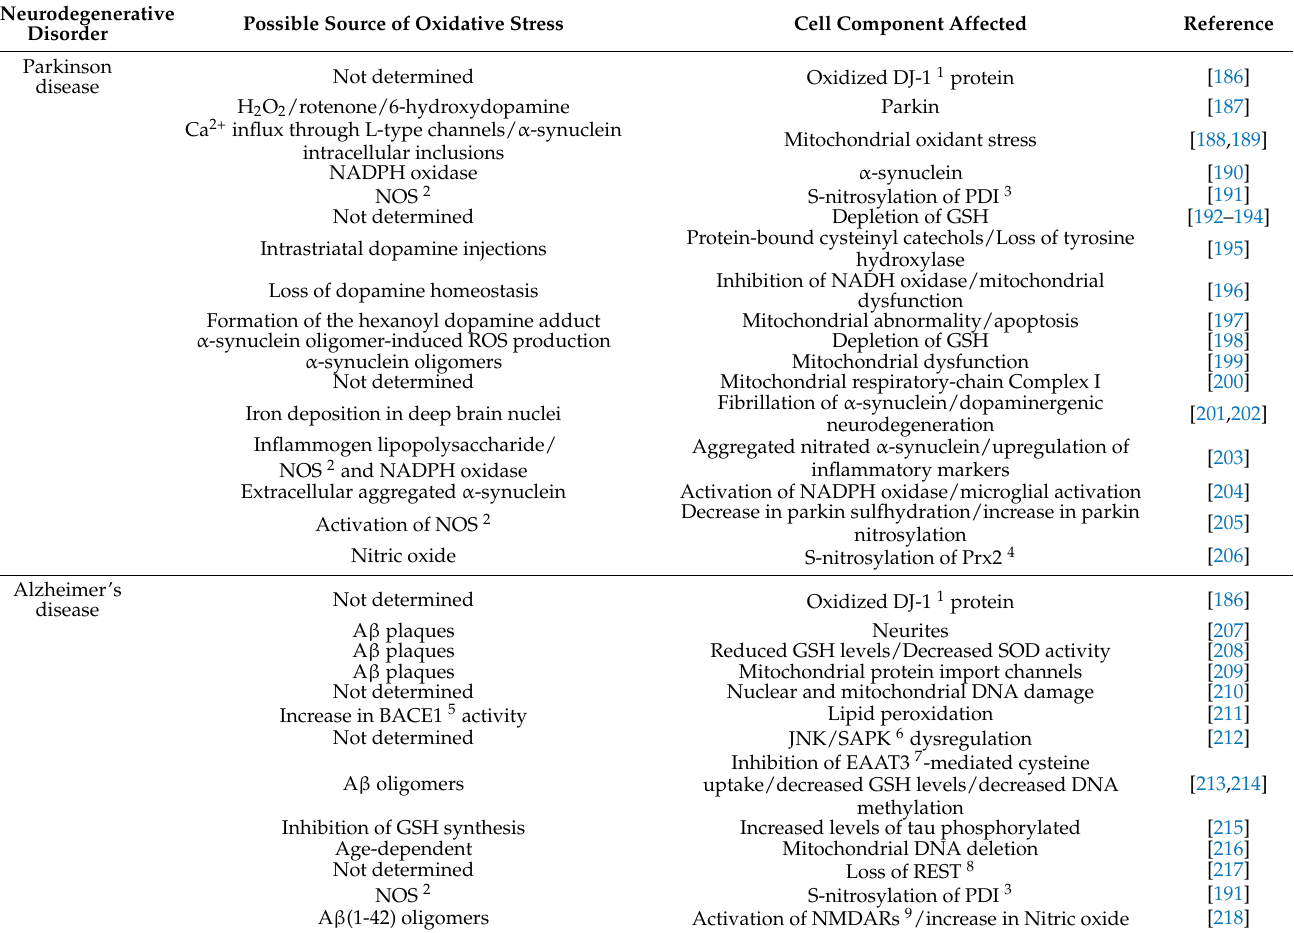
Table 1. Potential relations between oxidative stress and neurodegenerative disorders. Neurodegenerative Disorder Possible Source of Oxidative Stress